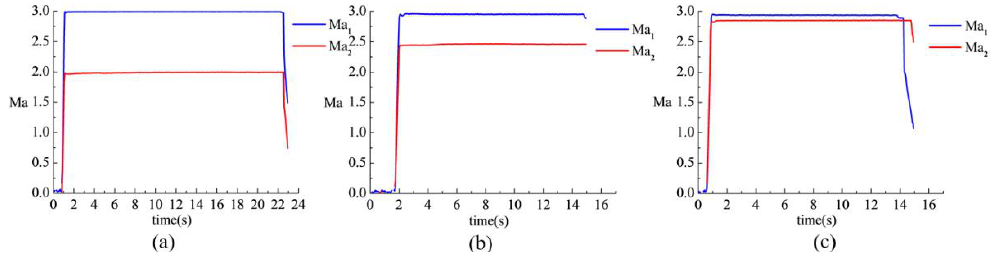
Figure 7. Mach number of the nozzles of the three cases ( a ) case 1, ( b ) case 2, ( c ) case 3. Table 2. Operation conditions of the wind